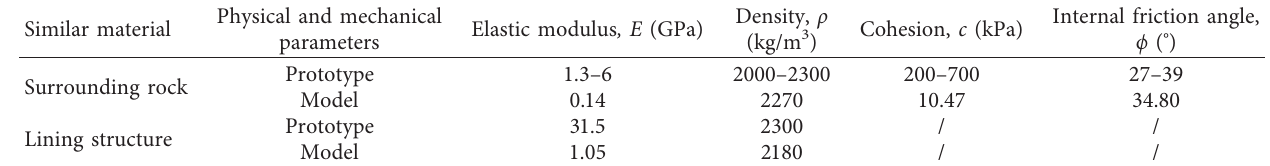
Table 2: Physical and mechanical parameters of similar materials.